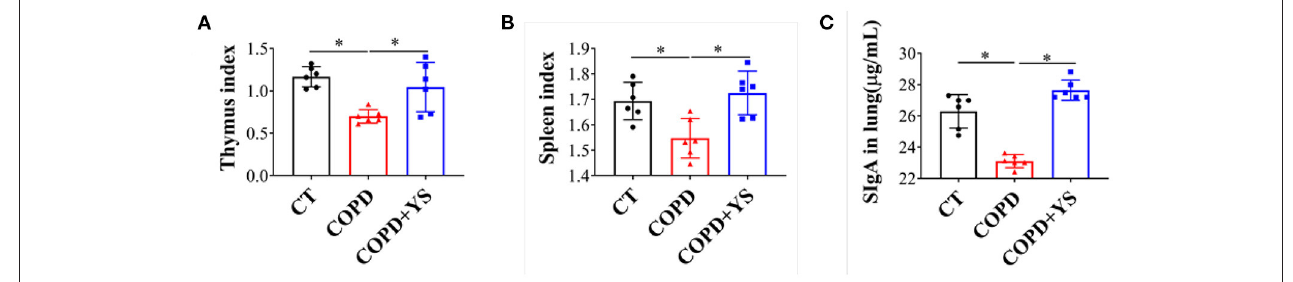
FIGURE 5 | (A) H&E staining of lung tissues of CT, COPD, and COPD + YS. (B) Masson staining of lung tissues of CT, COPD, and COPD + YS. (C) TNF- α in serum of CT, COPD, and COPD + YS ( n = 6). (D) IL-6 in serum of CT, COPD, and COPD + YS ( n = 6). (E) The relative expression of TGF- β 1 in the lung of CT, COPD, and COPD + YS ( n = 3). The data are presented as the means ± SEM of three experiments (* P < 0.05).